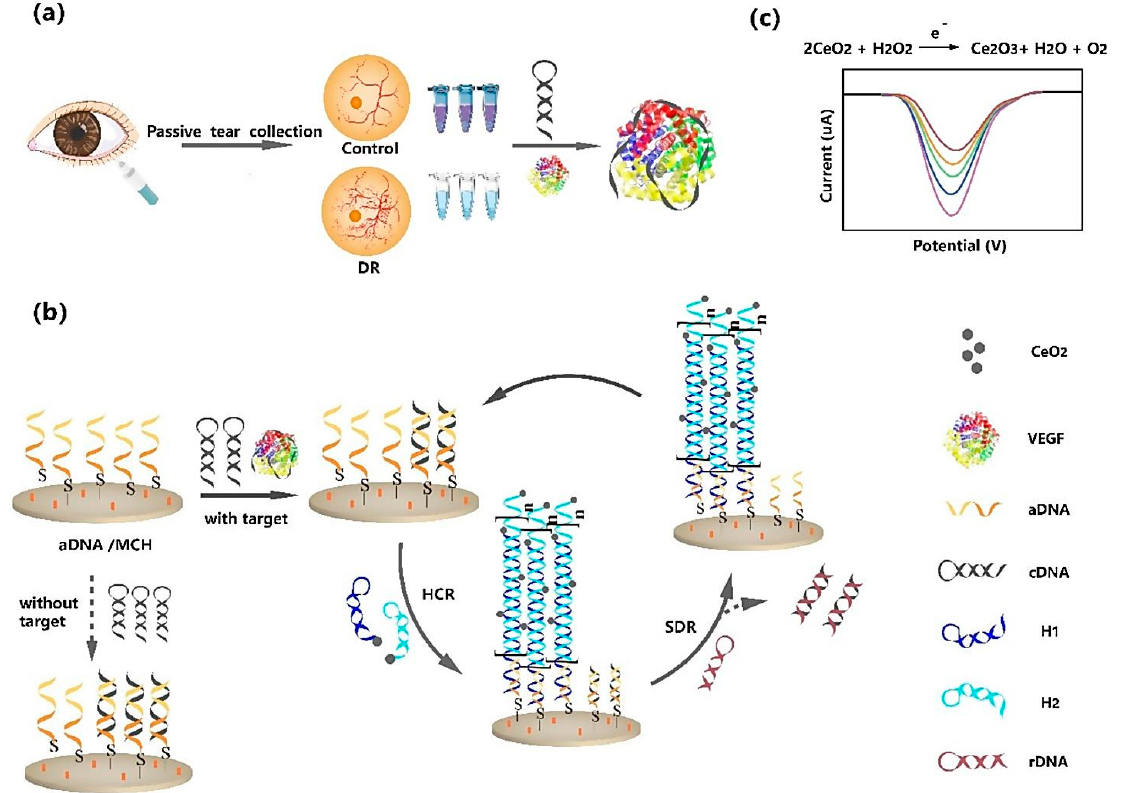
Figure 8. Schematic representation of a VEGF aptasensor with isothermal signal amplification strategy. ( a ) Capture of VEGF; ( b ) signal amplification strategy; ( c ) signal production. Reprinted from [63], with permission.